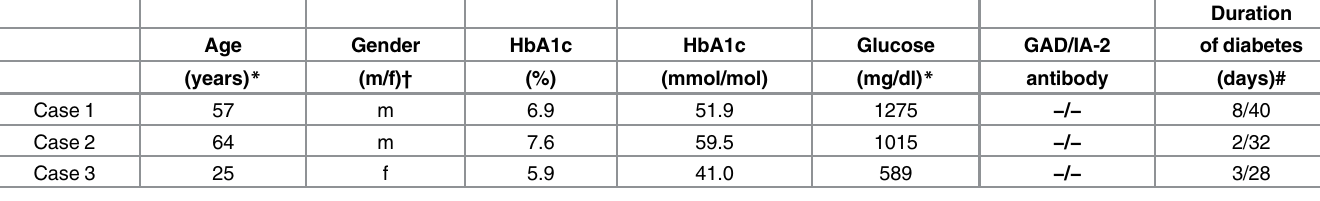
Table 1. Clinical characteristics of 3 patients with fulminant type 1 diabetes in seromic analysis.